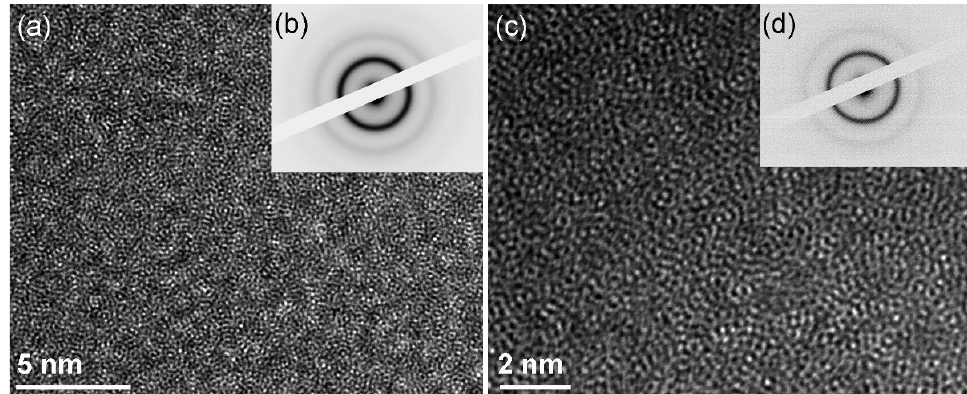
Figure 12. Atomic-resolution TEM images of the powders that were high-energy ball milled for 50 h of MD time for ( a ) Cu 50 Ti 40 Ni 10 and ( c ) Cu 50 Zr 40 Ni 10 systems. The corresponding NBDPs for both systems are displayed in ( b ) and ( d ), respectively.